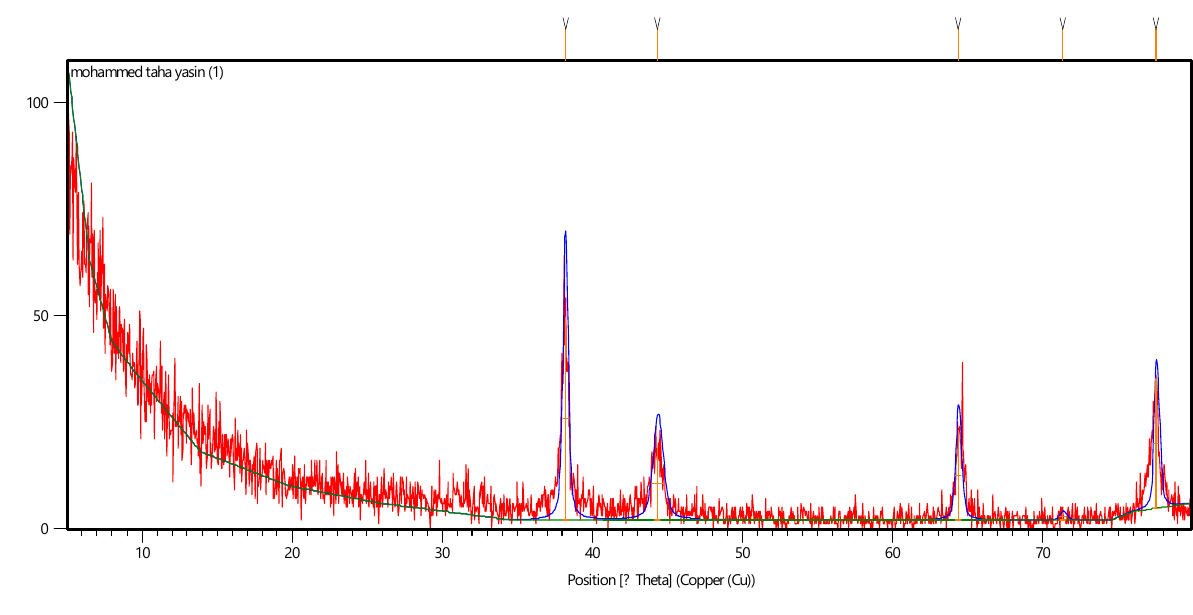
Figure 8. XRD pattern of the bio-inspired AgNPs.